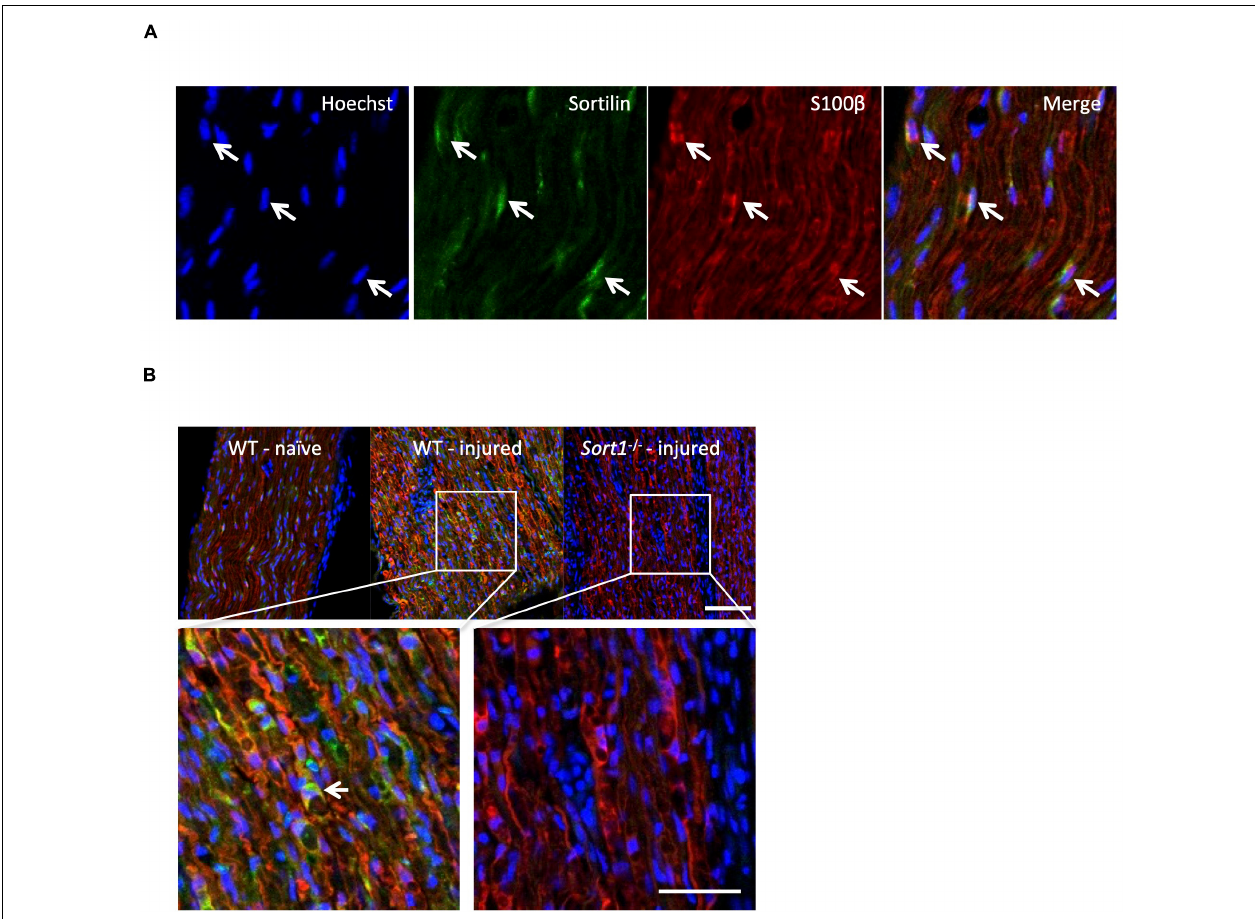
FIGURE 4 | Schwann cells of the sciatic nerve express sortilin. (A) Double-labeled immunofluorescence microscopy of sortilin (green) and s100 β (red) in longitudinal sections of wild-type (WT) naïve sciatic nerve. Nuclei are labeled with Hoechst (blue). White arrows demonstrate Schwann cells expressing sortilin. Scale bar 50 µ m. (B) Double-label immunofluorescence microscopy of sortilin (green) and s100 β (red; Schwann cell marker) in longitudinal sections of naïve sciatic nerves and 5 days after crush injury in WT and Sort1 − / − distal sciatic nerves. Nuclei are labeled with Hoechst (blue). The white arrow points to a sortilin-positive (green) s100 β -positive (red) WT Schwann cell. Scale bar 100 µ m upper images and 50 µ m lower